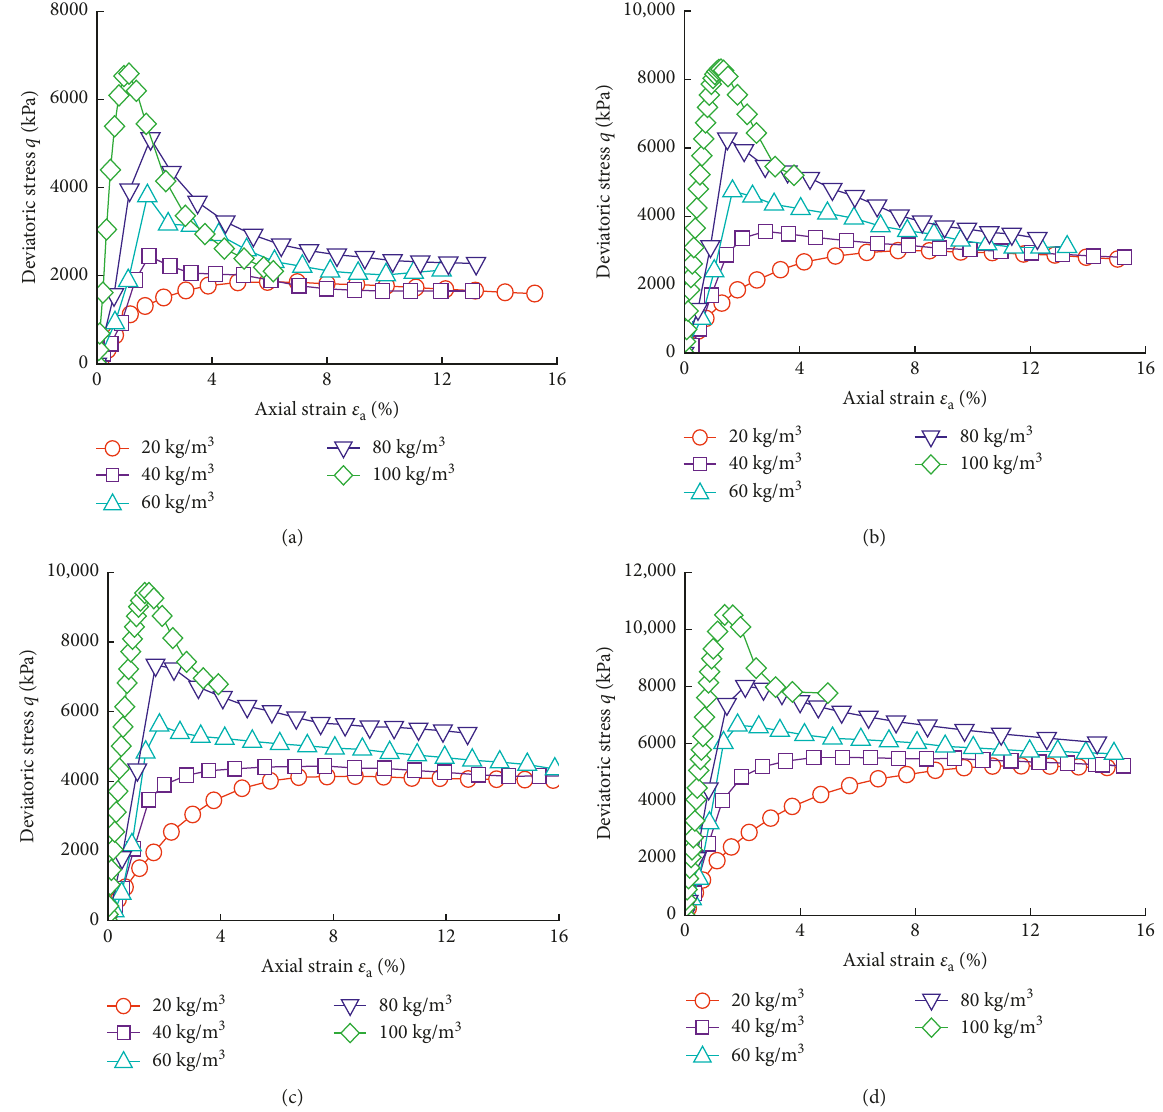
Figure 3: Stress-strain curves of Material I with regard to the effect of cementing agent content under various confining pressures: (a) 300kPa; (b) 600kPa; (c) 900kPa; (d)